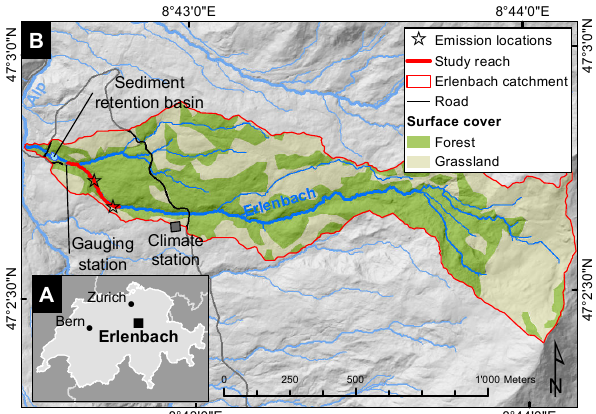
Figure 1. Overview map of the Erlenbach catchment showing (a) its position within Switzerland as well as (b) its topography, in- strumentation features and the study reach (cf. Fig. 4). Data source: DTM-AV © 2014 Swiss Federal Directorate of Cadastral Surveying (DV033531). Table 1. Catchment characteristics of the Erlenbach stream in Switzerland (cf. Turowski et al., 2009; Badoux et al., 2012). Catchment parameter Value Basin area (km 2 )